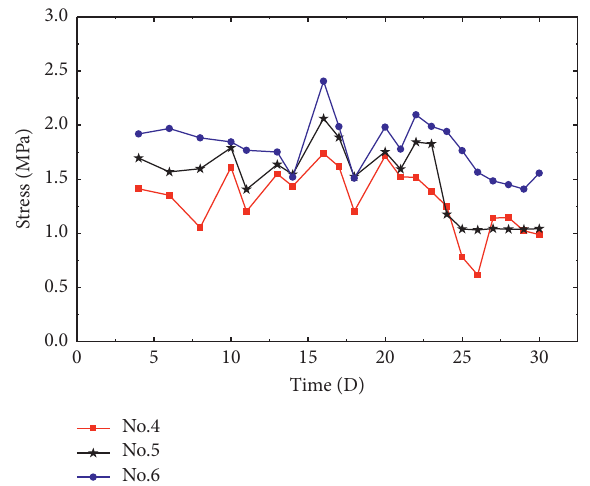
Figure 10: Variations of the interaction stress between the hori- zontal shaft lining and the surrounding rock at an ingate depth of −